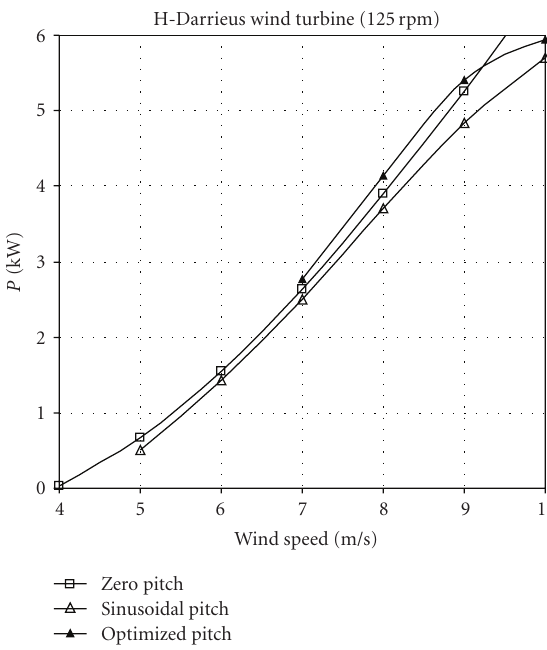
Figure 8: Power versus wind speed for the 7kW VAWT with fixed and optimized variable pitch